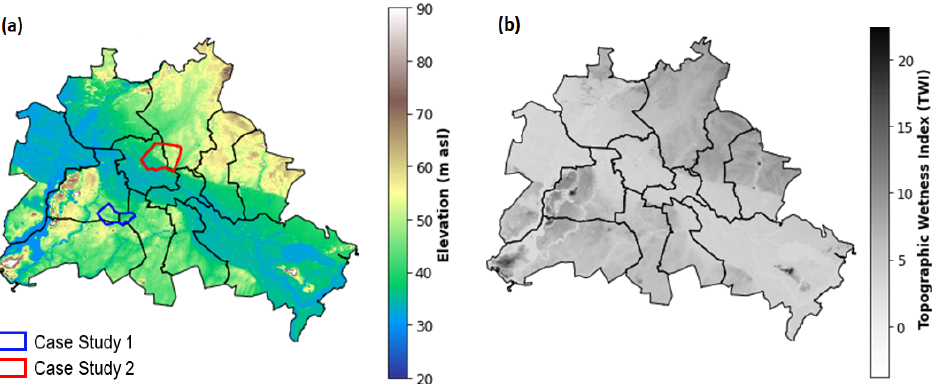
Figure 1. ( a ) Digital elevation model (DEM) of Berlin, the two case studies and the city districts. ( b ) The spatial distribution of TWI for Berlin and the city